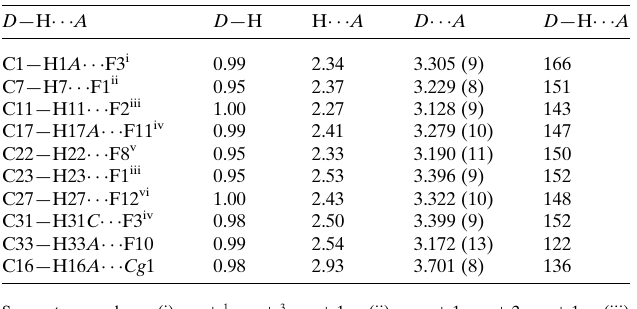
Table 3 Experimental details. Crystal data Chemical formula